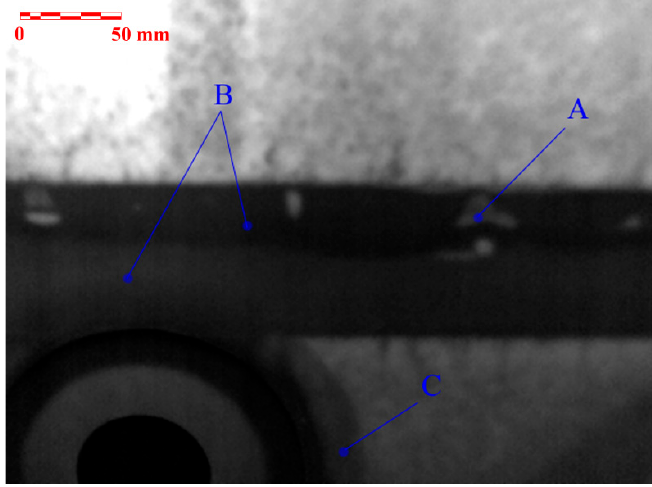
Figure 18. Results of the PT NDE method: adhesive joint of the front wing spar and the upper wing side in the fuel tank area.